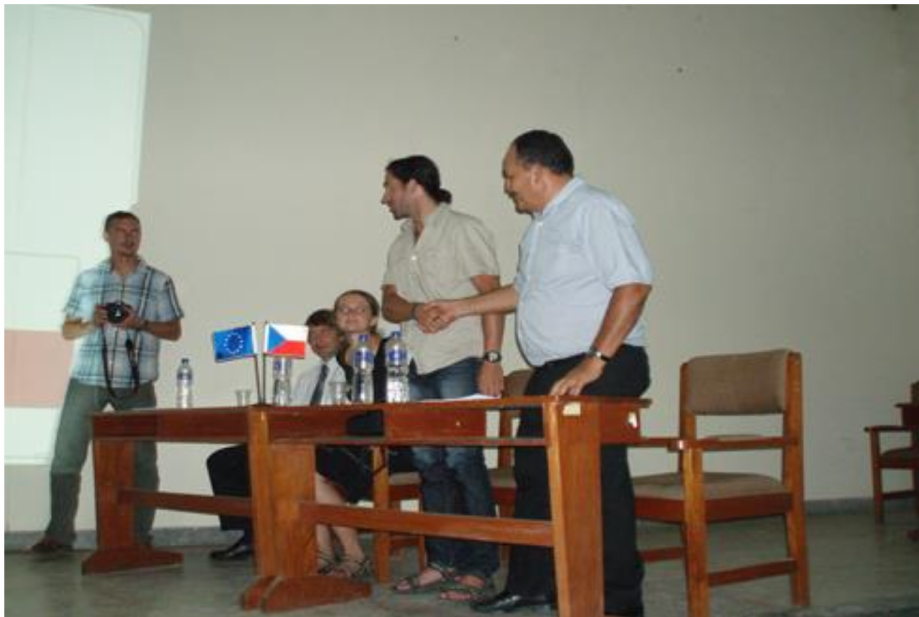
Figure 7. Signing of the contract between POPRAR and Cooperativa Yanesha, Peru.5.3. Content